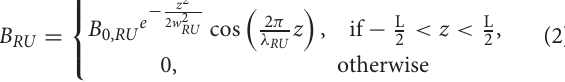
TW-class table-top light sources with pulse